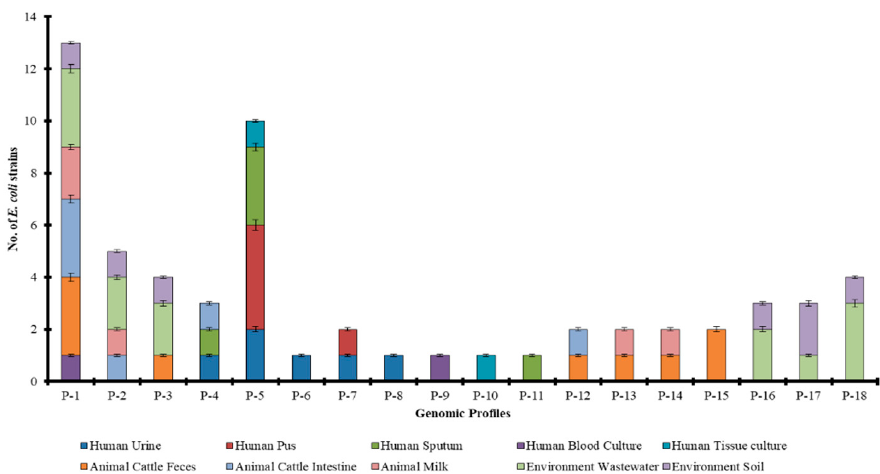
Figure 2. Dissemination pattern of genetic profiles among human, animal, and environmental origins and sources.